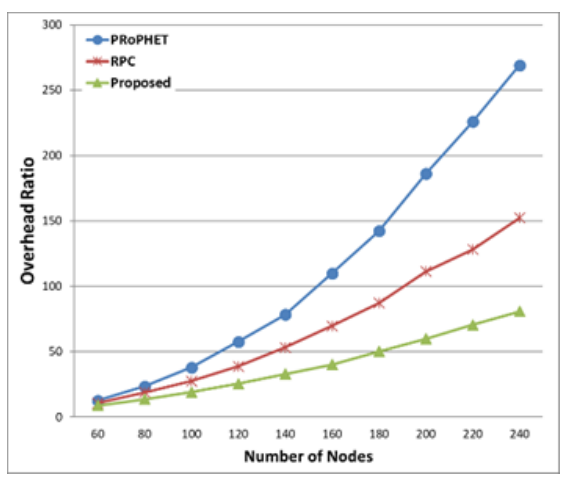
Figure 12. Overhead ratio for different number of nodes.